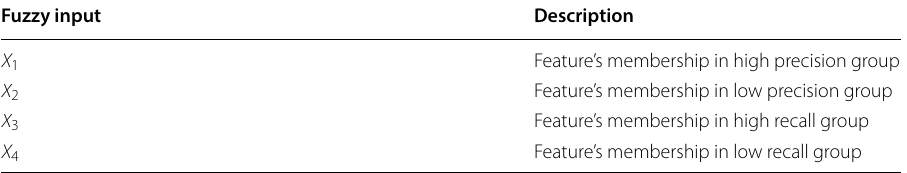
Table 2 Example fuzzy input variables Fuzzy